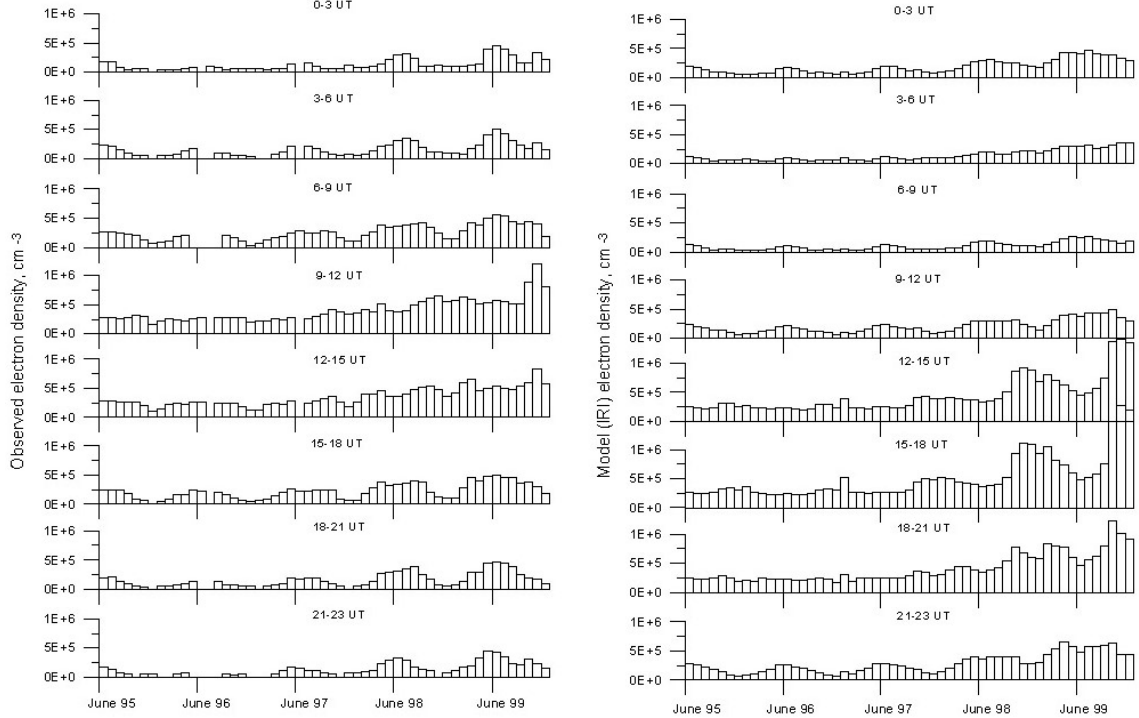
Fig. 5. (a) Electron density in the maximum of the F-layer ( N emax ) obtained from monthly median values of fo F2 measured by ionosonde in SGO within 3-h intervals during 1995–1999. (b) Electron density in the maximum of the F-layer ( N emax ) above Sodankyl¨a according to the IRI model for the middle of every 3-h interval of the middle day of every month during